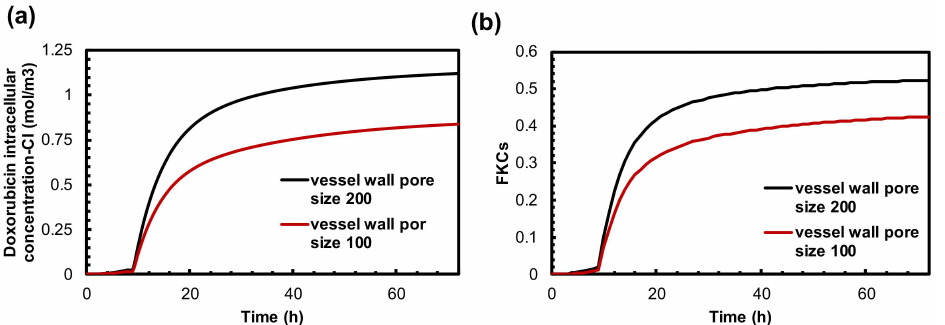
Figure 6. The effect of tumor vessel wall pore size on treatment efficacy of combination therapy. ( a ) Intracellular concentration of Dox is much higher in high permeable tumors. ( b ) FKCs over time. Therapeutic efficacy of TSLs in the presented combination therapy restricted in low permeable tumors. The efficacy of treatment is reduced as much as that of conventional